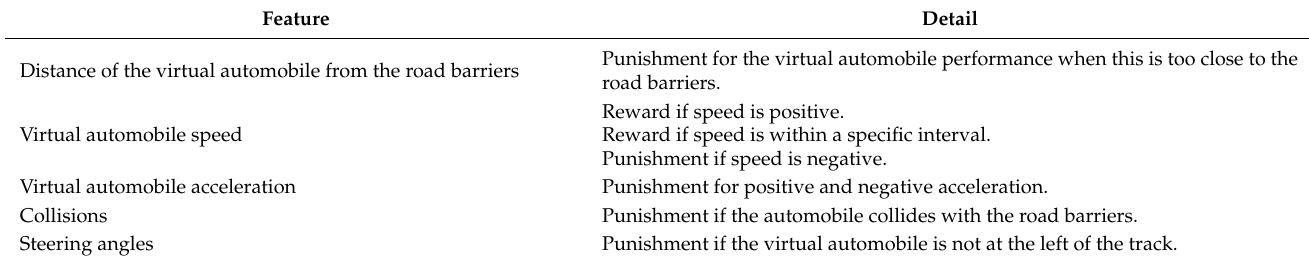
Table 6. Design criteria.